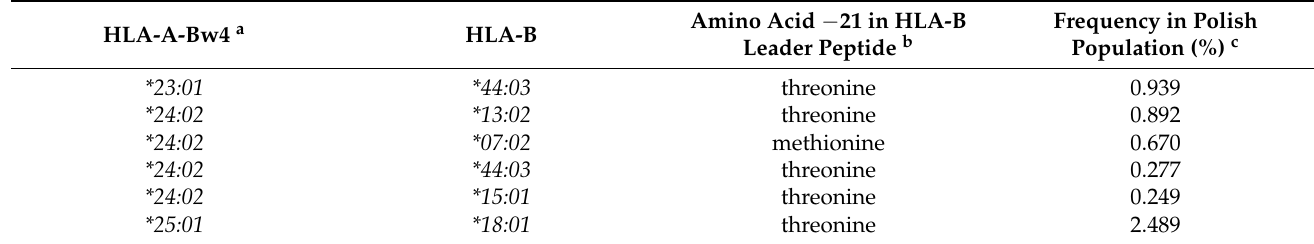
Table 6. Frequencies of HLA-A-Bw4, HLA-B haplotypes and amino acid residue − 21 in HLA-B leader